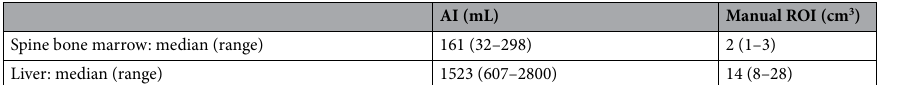
Table 5. Volumes used by the artificial intelligence (AI)-based method compared with the manual method for the SUV index calculations. ROI = Region of